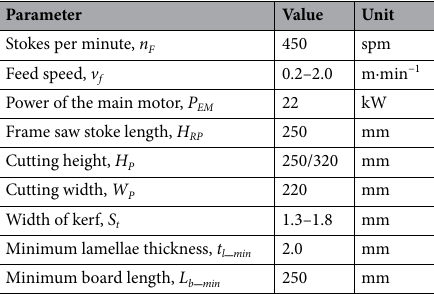
Table 1. The basic parameters of the frame sawing machine Mamuth.